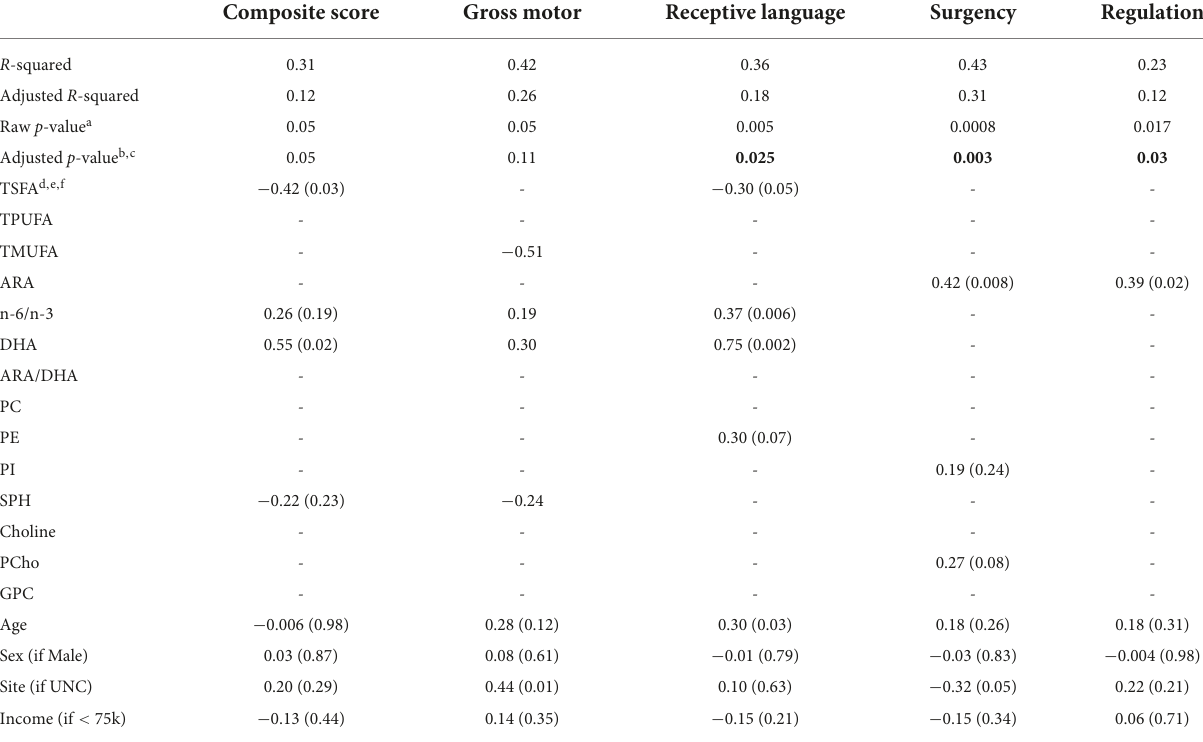
TABLE 6 Multiple regression results for MSEL scores/IBQ-R factors with the selected